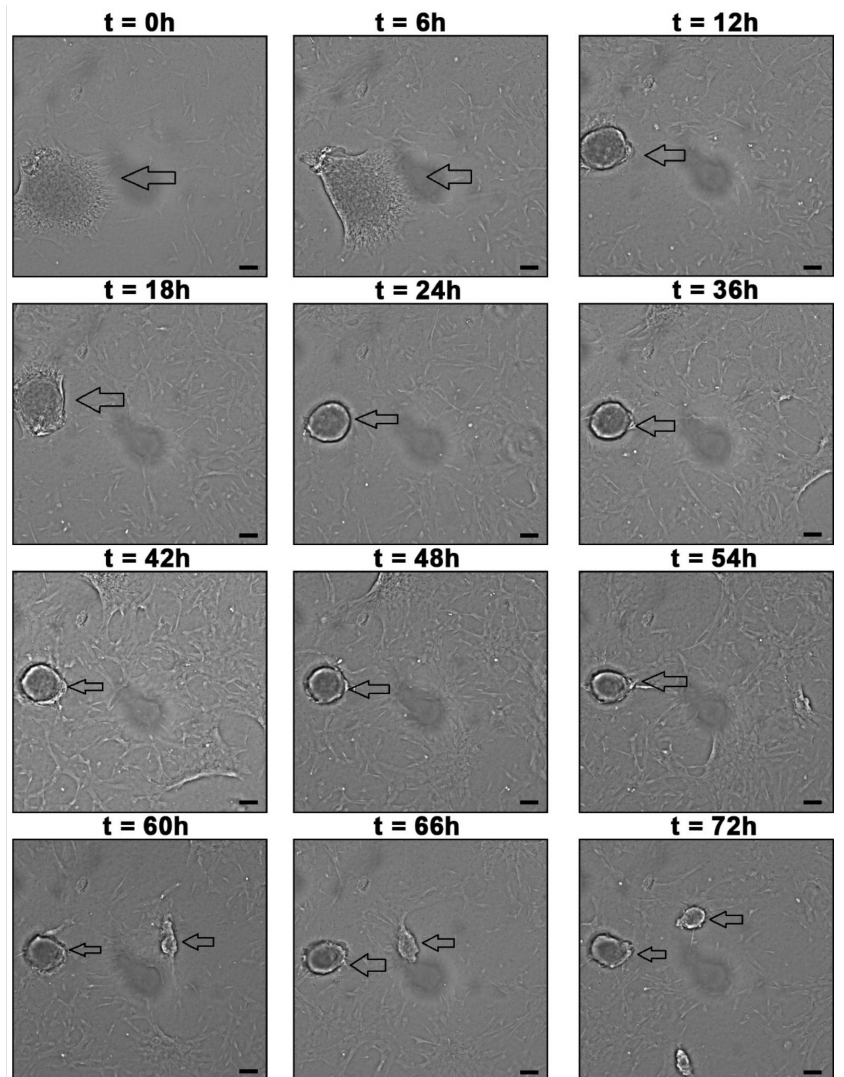
Figure 6. Formation of WJ-MSC-derived neurospheres in 72 h. The arrows point to neurospheres. The images were taken with InCell Analyzer 2000, GE (100 X). Scale bar, 100 µ m.